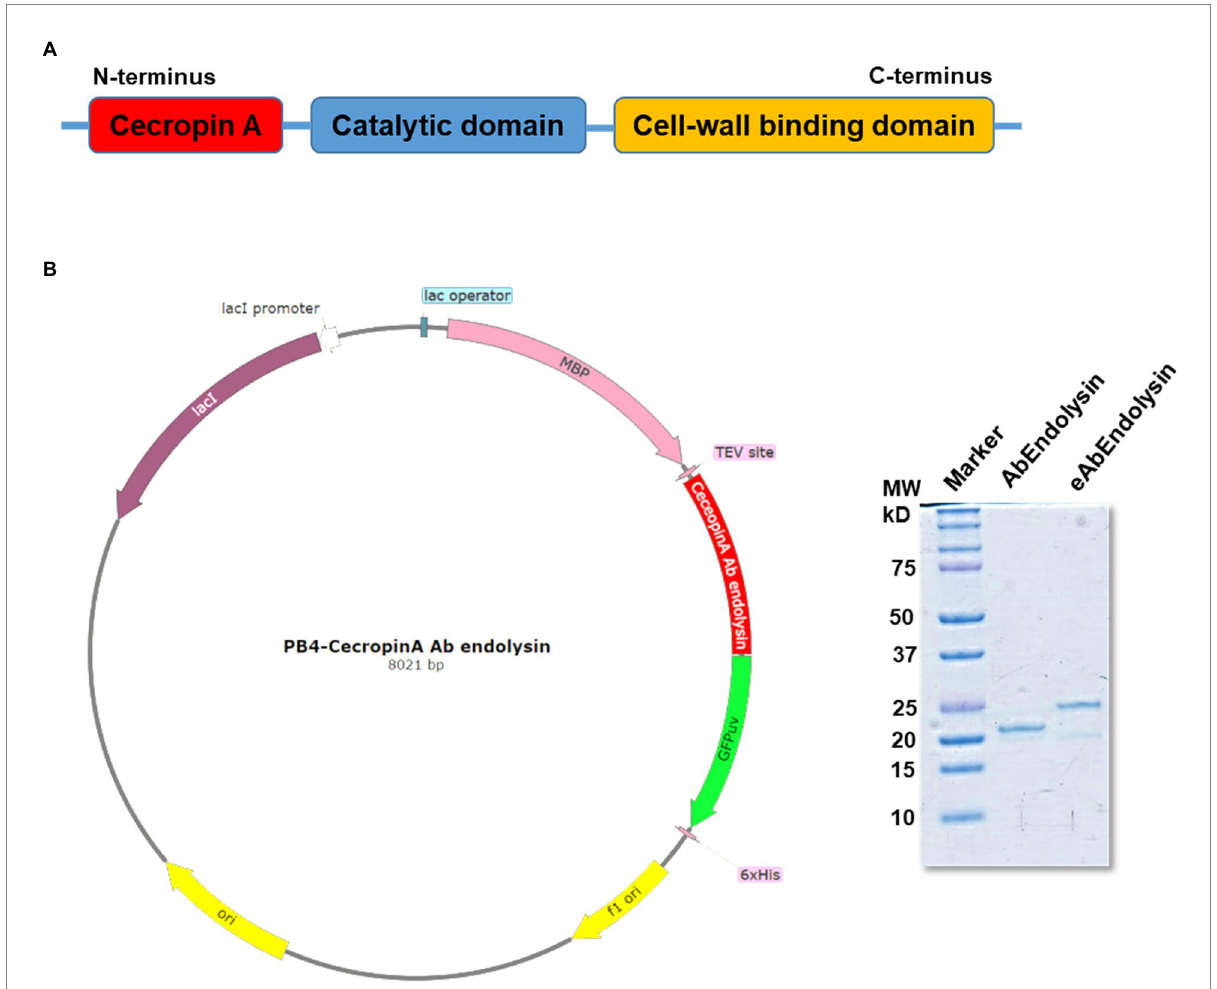
FIGURE 1 Cloning and purification of cecropin A-fused AbEndolysin. (A) Fusion of cecropin A at N-terminus of AbEndolysin comprising two domains: N-terminal catalytic domain (sky blue color) and C-terminal cell-wall binding domain (yellow color). (B) Overall scheme used for the purification of eAbEndolysin. Purified recombinant endolysin was separated using a 12% sodium dodecyl sulfate polyacrylamide gel. Lane 1: marker, Lane 2: 22 kDa AbEndolysin, and Lane 3: 26.5 kDa